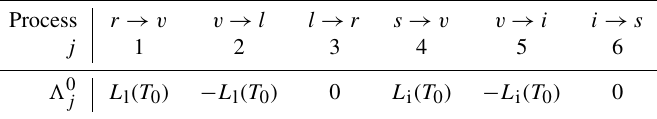
Table 2. Variables (cid:51) 0